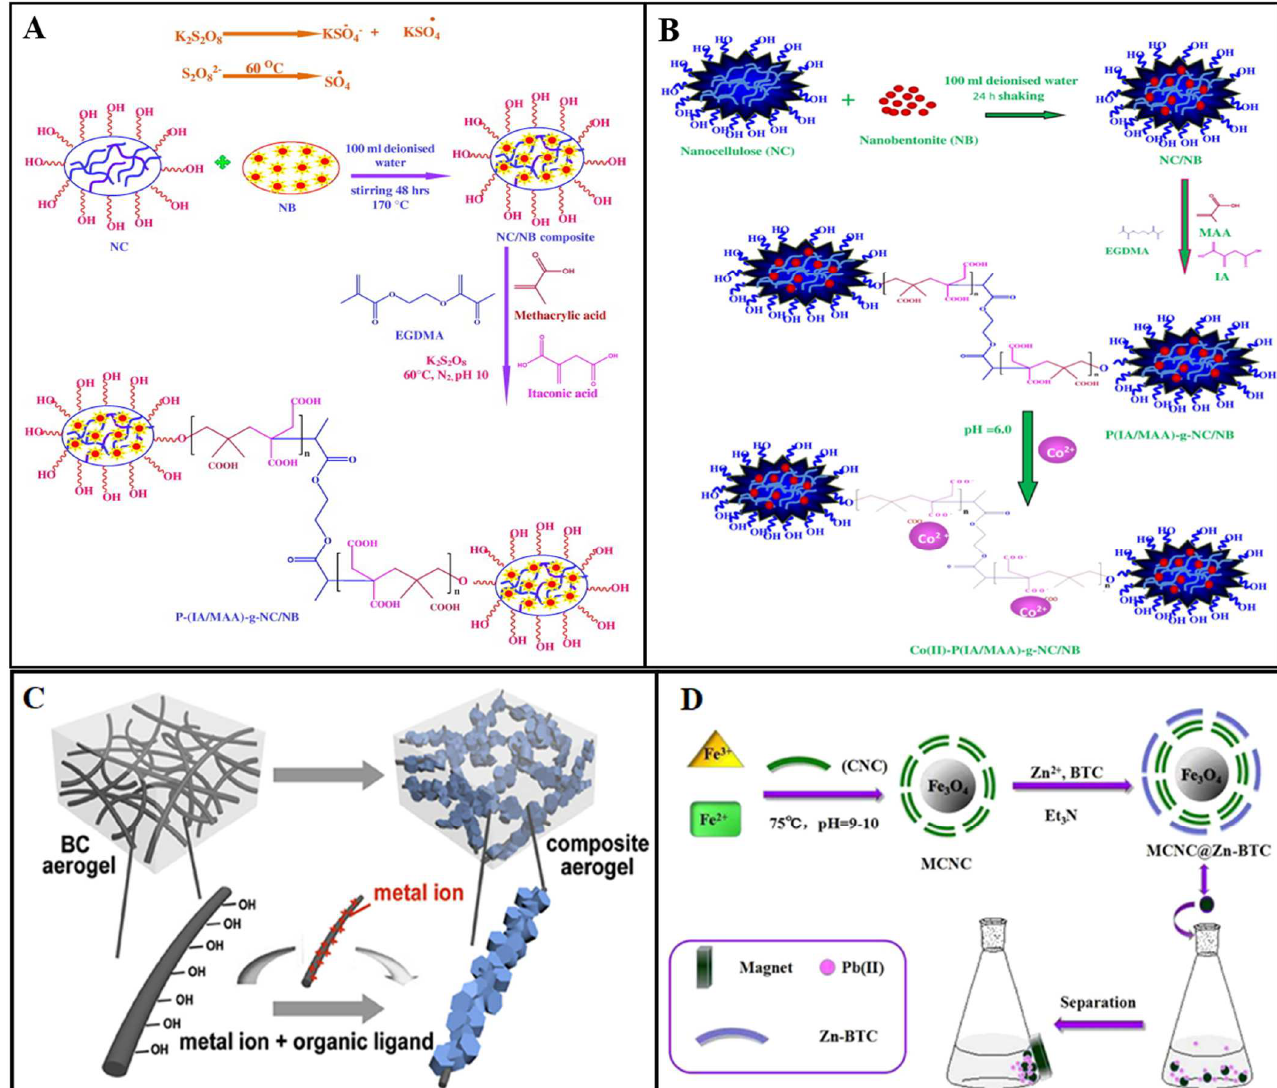
Figure 9. Synthesis of ( A ) P(IA/MAA)-g-NC/NB, ( B ) Co(II) P(IA/MAA)-g-NC/NB, ( C ) BC@MOFs composite aerogels, and ( D ) MCNC@Zn-BTC. Adapted with permission from [116]. Copyright 2015 Elsevier. Adapted with permission from [117]. Copyright 2016 Elsevier. Adapted with permission from [118]. Copyright 2019 Elsevier. Adapted with permission from [119]. Copyright 2017 American Chemical Society.